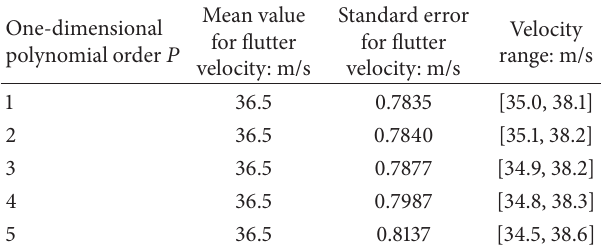
Table 1: Flutter uncertainty by the PCE method.